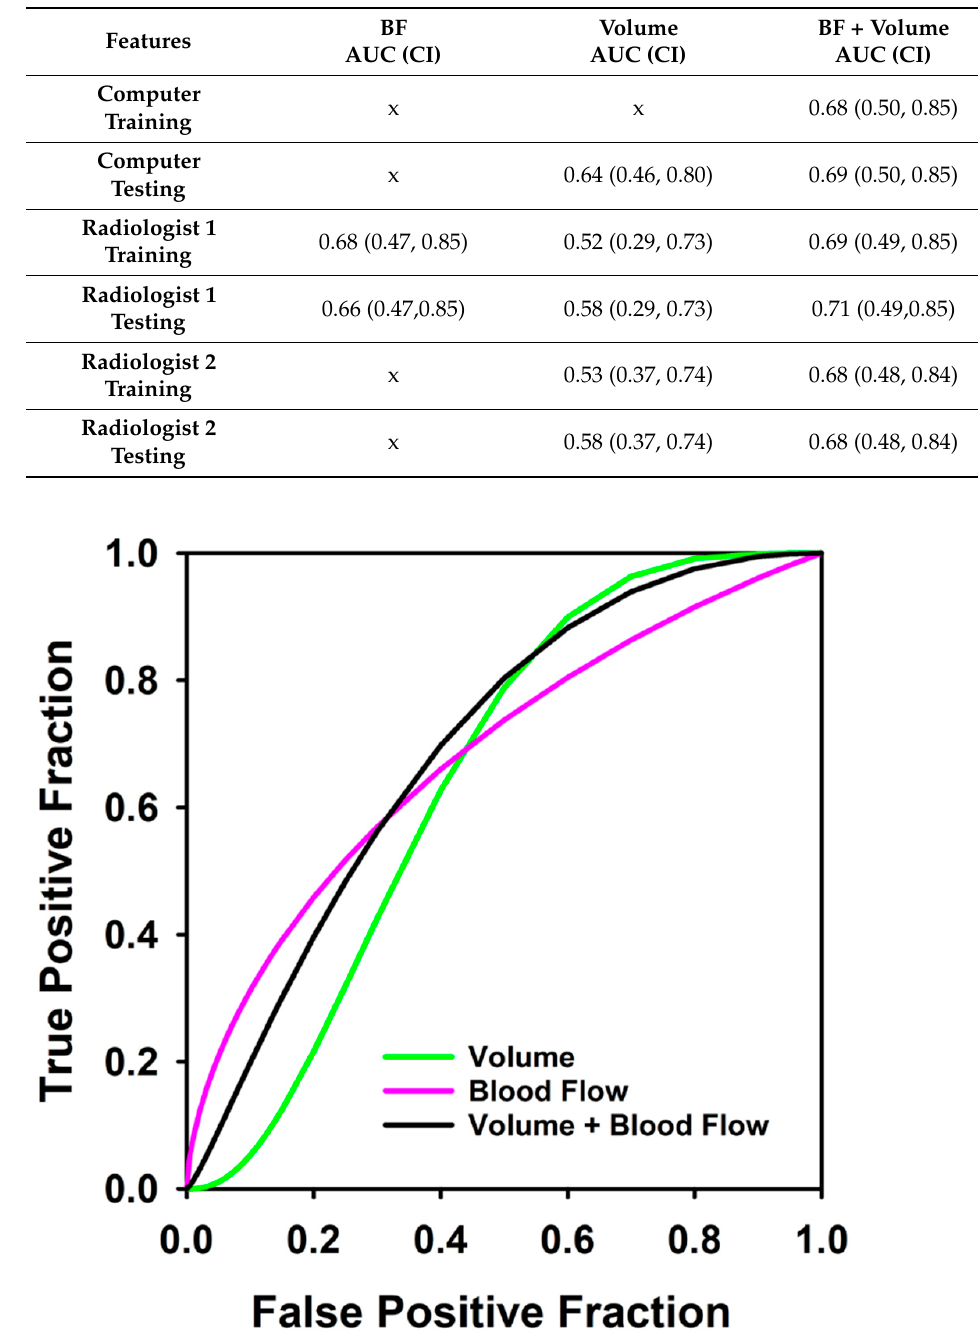
Figure 3. Receiver operating characteristic curves for predicting which patients would not achieve disease free survival at 1 year using blood flow change alone (AUC = 0.66), percent volume change by computer contouring (volume) (AUC = 0.64), and the combined response index for 36 pre- and post-induction therapy tumors (AUC = 0.69).